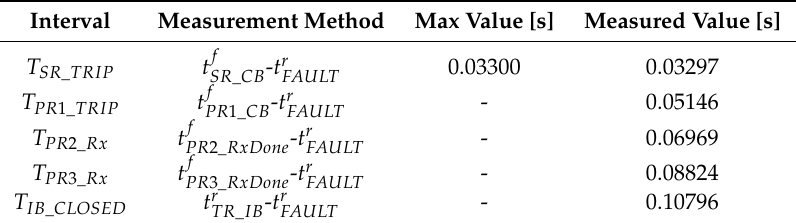
Table 11. Estimated time intervals during the fault 50.S3 between SR and PR1.